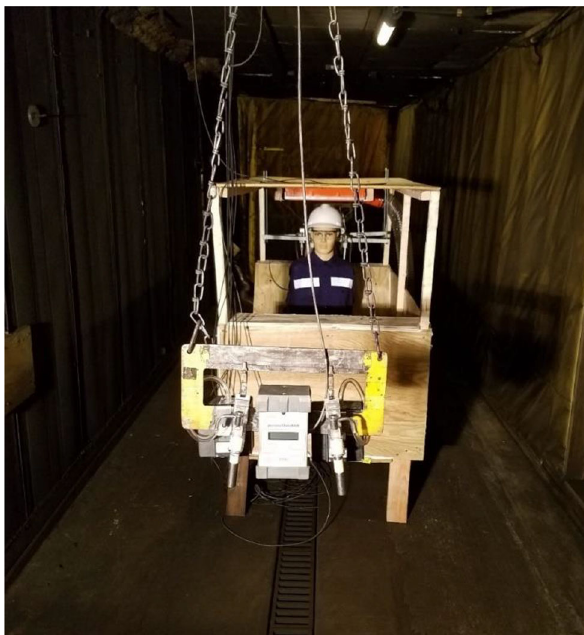
Fig. 4 Photo showing the setup of the center-drive cab for testing with the manikin used for centering the CAC over the shuttle car operator